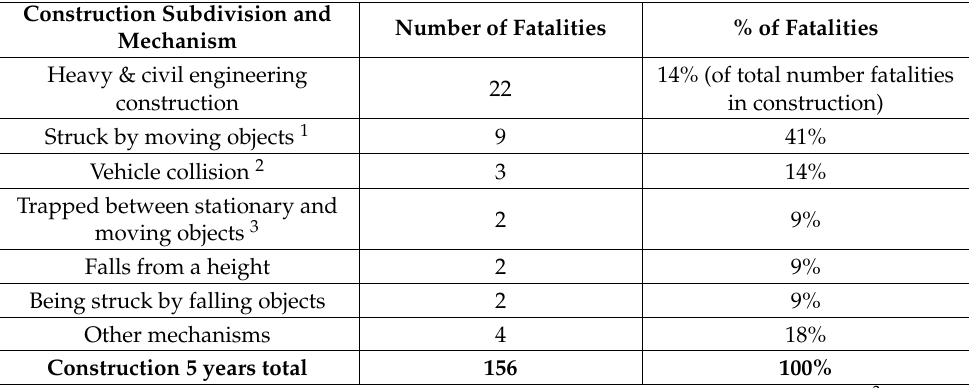
Table 2. Number of fatal accidents by cause (according to TOOCS—Type of Occurrence Classification System of Australian Government) in “Heavy and Civil Engineering Construction” sector from 2014 to 2018 (combined) (source: Safe Work